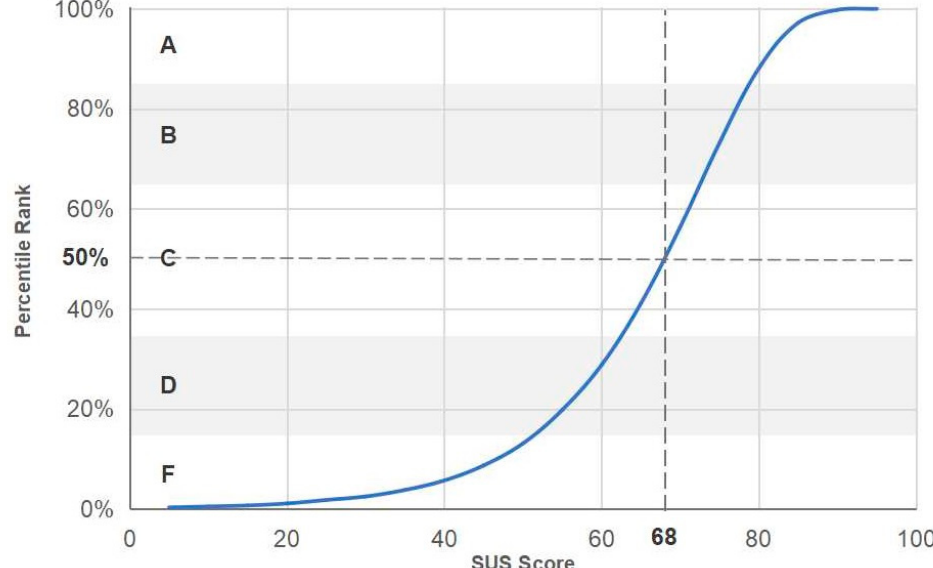
Figure 16. SUS score—Percentiles are assigned grades from A to F.